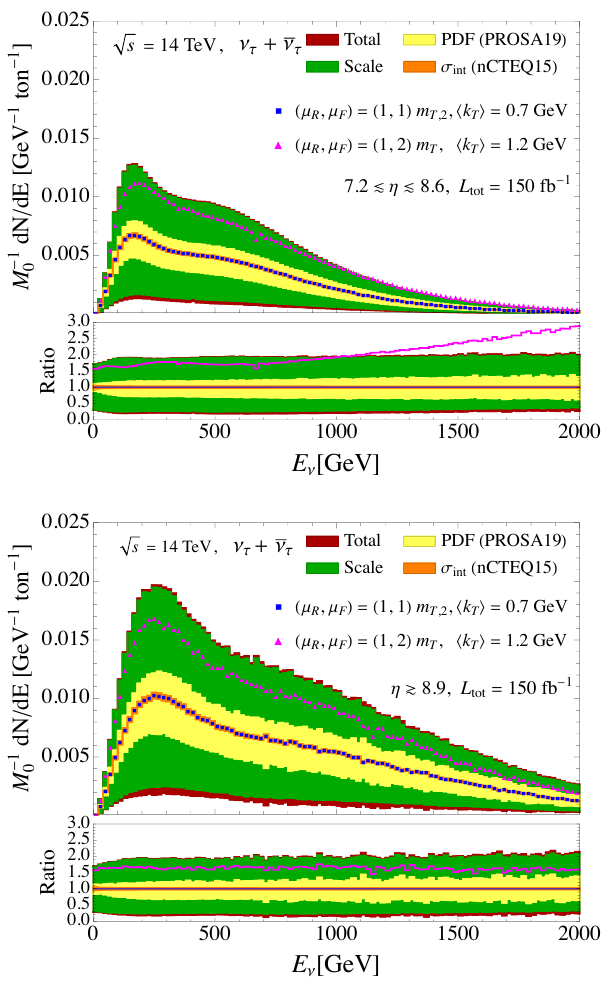
Figure 18. Energy distribution of tau neutrino and antineutrino CC interaction events per ton of detector at a distance D d = 480 m from the collider interaction point, in the pseudorapidity ranges of 7 . 2 < η ν < 8 . 6 (upper) and η ν > 8 . 9 (lower). Central predictions refer to ( µ R , µ F ) = (1 , 1) m T, 2 and h k T i = 0.7 GeV. The presented uncertainties are due to seven variations of the QCD scales (green) around the central value, the PDF uncertainty sets of the PROSA FFNS fit [26] (yellow) and of the nCTEQ15 fit for tungsten [60] (orange) used for production and interaction, respectively, as well as the combination of the QCD and PDF uncertainties. Central predictions with ( µ R , µ F ) = (1 , 2) m T and h k T i = 1.2 GeV are also shown (magenta triangles) for comparison. The corresponding ratios to the central predictions of energy distributions of charged-current event numbers with error bands and with ( µ R , µ F ) = (1 , 2) m T and h k T i = 1.2 GeV are shown in the ratio